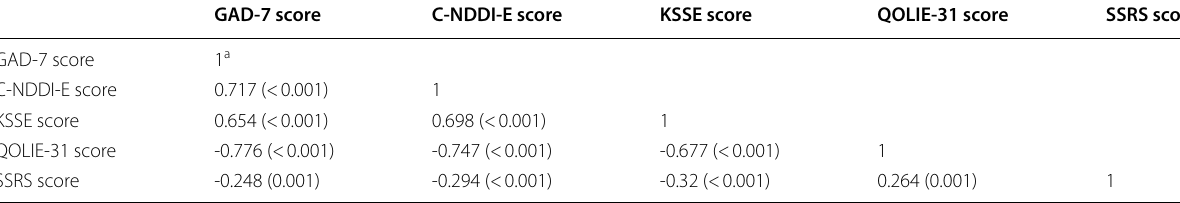
GAD-7 Generalized Anxiety Disorder-7, NDDI-E Neurological Disorders Depression Inventory for Epilepsy, KSSE Kilifi Stigma Scale of Epilepsy, QOLIE-31 Quality of Life in Epilepsy Inventory, SSRS Social Support Rating Scale